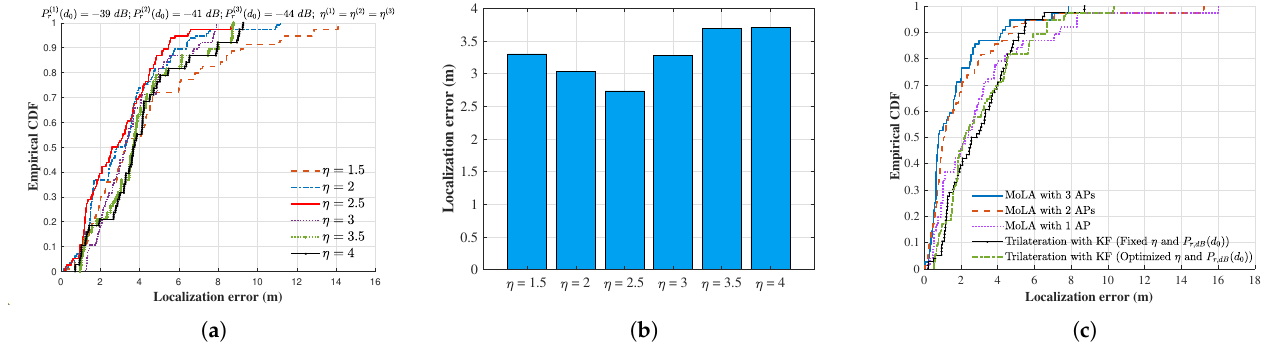
Figure 8. Comparison of localization errors with multi-AP MoLA and optimized trilateration with the KF. ( a ) Impact of different path loss exponents on the localization error of conventional trilateration with the KF; ( b ) localization error with different path loss exponents; ( c ) localization error with multi-AP MoLA and trilateration with the